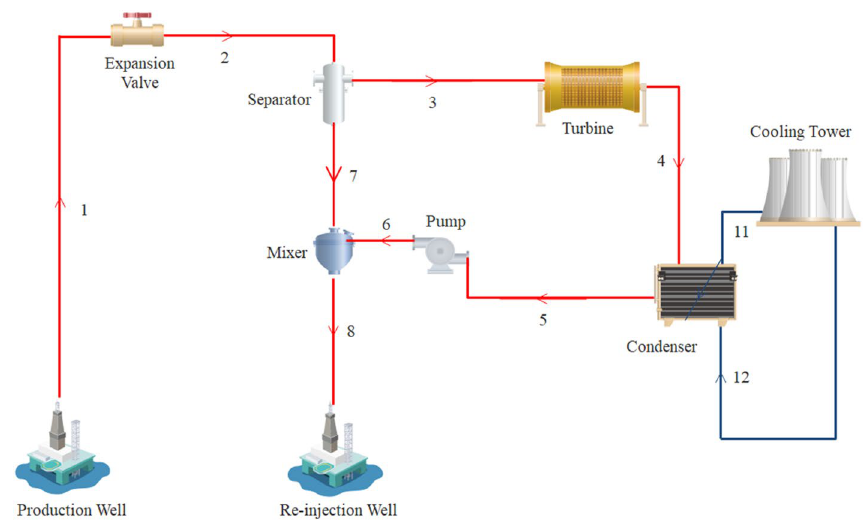
Fig. 1 Single flash geothermal cycle diagram